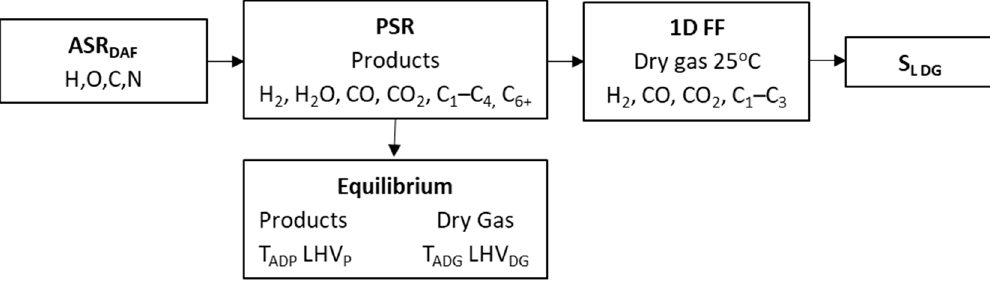
Figure 3. Numerical modelling workflow. Dry ash free (DAF), perfectly stirred reactor (PSR), 1D FreeFlame model (1D FF), laminar flame speed (S L DG ), lower heating value of the dry gas (LHV DG ), and raw pyrolysis products (LHV P ).